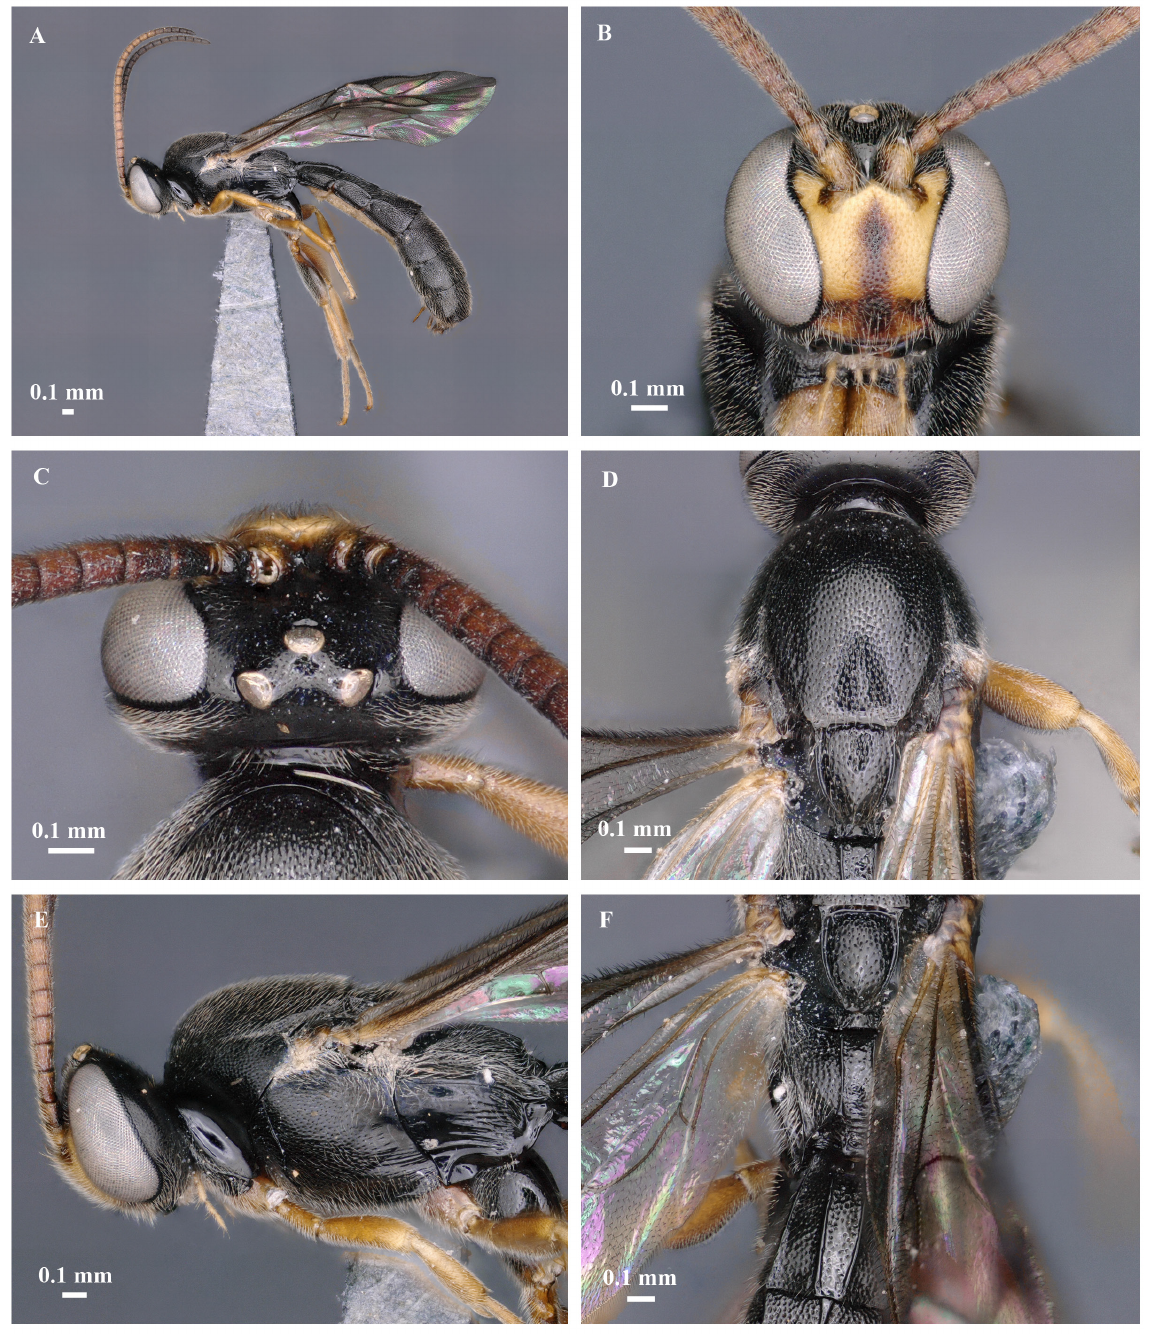
Fig. 5. Trieces orientalis sp. nov., holotype, ♀ (AIMB). A . Habitus, lateral view. B . Head, anterior view. C . Head, dorsal view. D . Mesosoma, dorsal view. E . Head and mesosoma, lateral view. F . Propodeum, dorsal